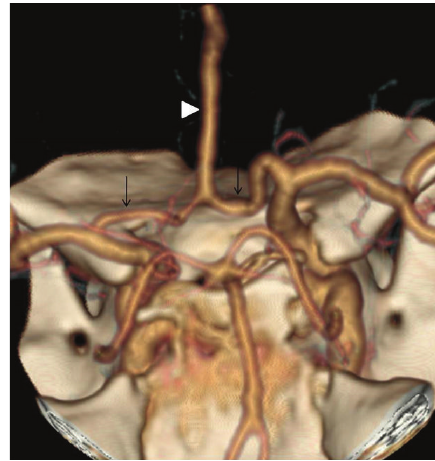
Figure 4: Right vertebral injection. The right PICA gives branches to supply the PICA territory in the left